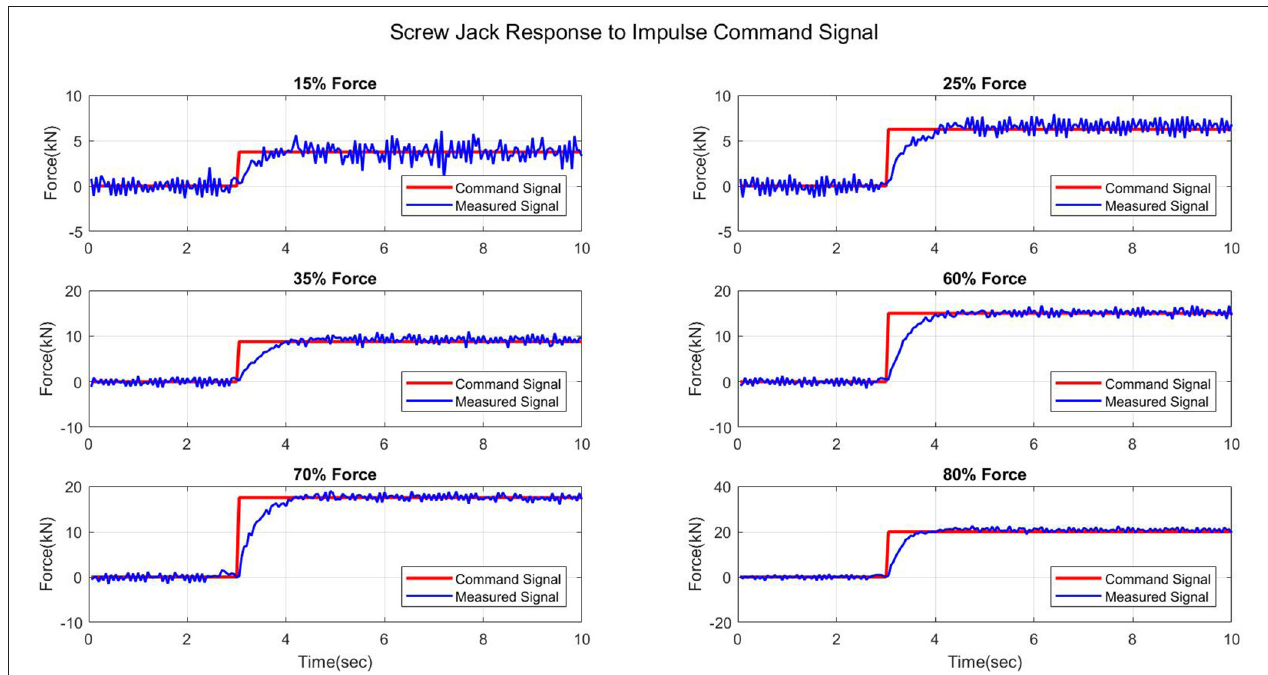
FIGURE 3 | Screw jack characterization tests: step force command vs. measured force.